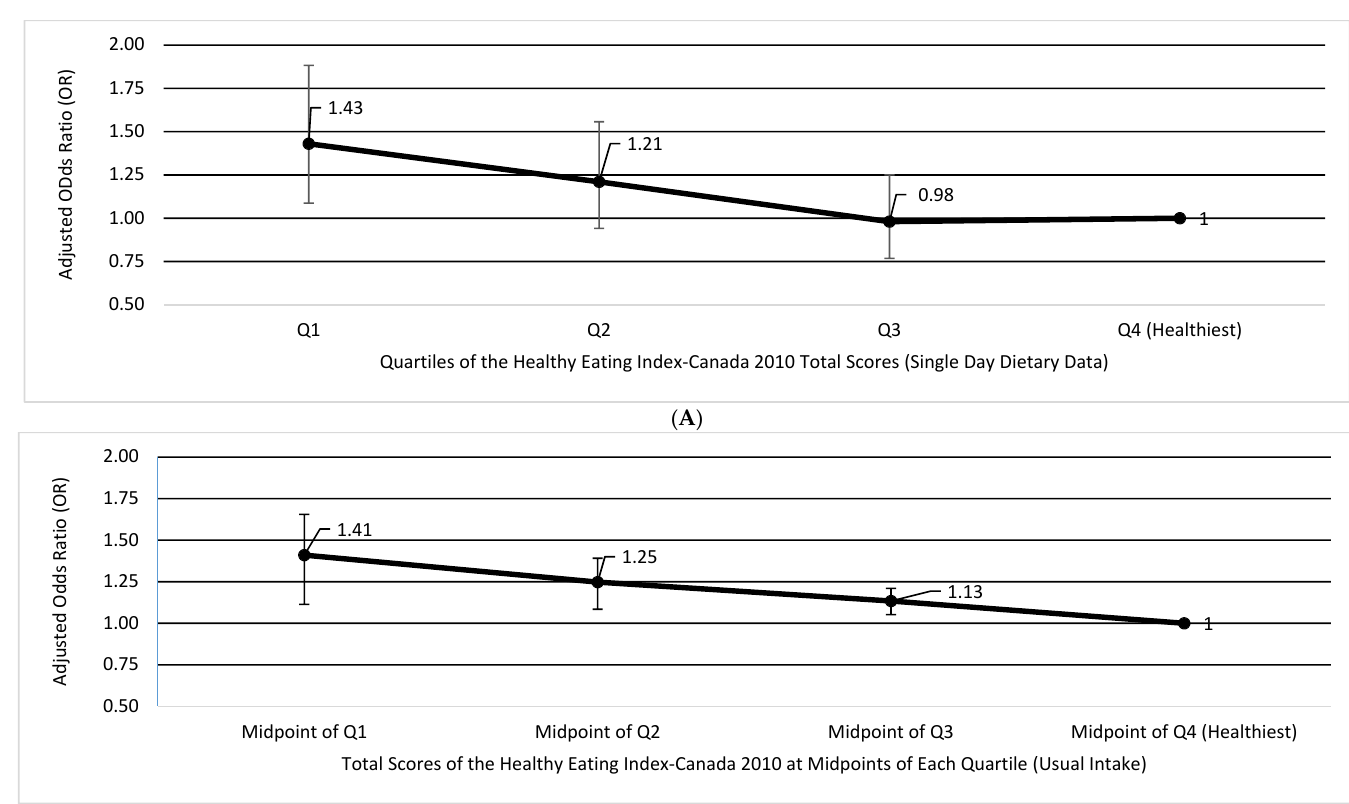
Figure 3. Weighted multivariate adjusted odds ratios (OR) and 95% confidence intervals (CI) representing the likelihood of being obese (BMI ≥ 30 kg/m 2 ) for ( A ) quartile categories (Q) of HEI ‐ C 2010 among Canadian adults ( n = 12,805) using one day of dietary recall data with Quartile 4 as the reference, and ( B ) for estimated usual HEI ‐ C 2010 scores derived from the NCI method, with estimated total scores entered as continuous. Four data points are shown (percentiles: 12.5, 37.5, 62.5, 87.5) corresponding to the midpoint of each quartile. Both models are adjusted for age, sex, energy, physical activity level, smoking status, and misreporting status. HEI ‐ C: Healthy Eating Index ‐ Canada; BMI: body mass index.